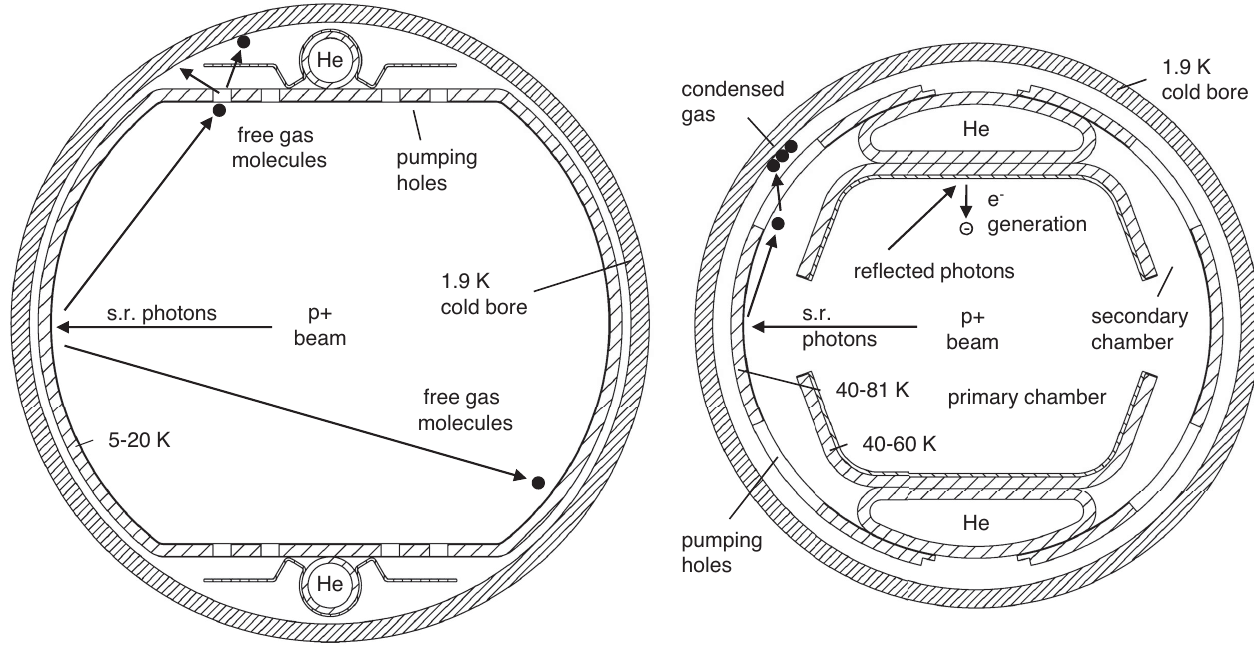
FIG. 1. Comparison of the beam screen of the LHC, as seen in [10], and the FCC-hh ’ s. Both figures are represented at the same scale. The inner diameter of the cold bore is 50 mm in the LHC and 44 mm in the